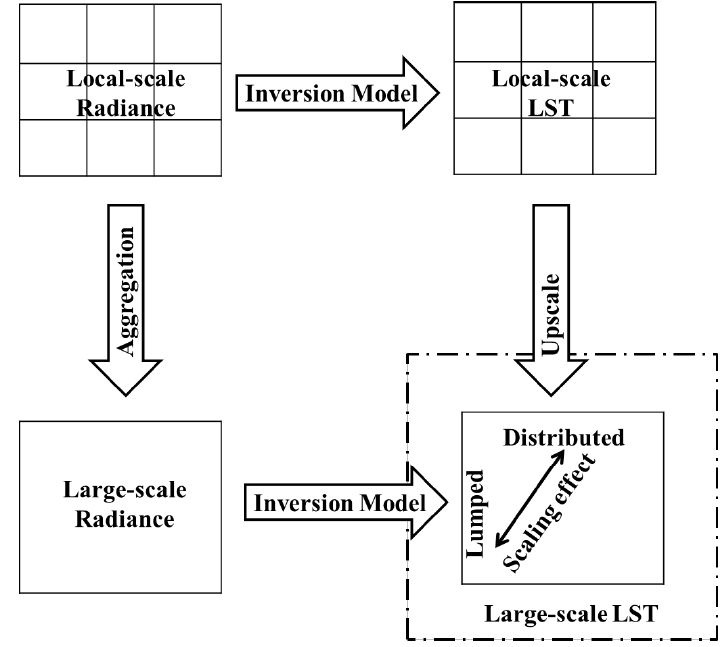
Figure 2. Schematic of the comparison between the distributed and lumped LSTs. The same inversion model is used in the distributed method and the lumped